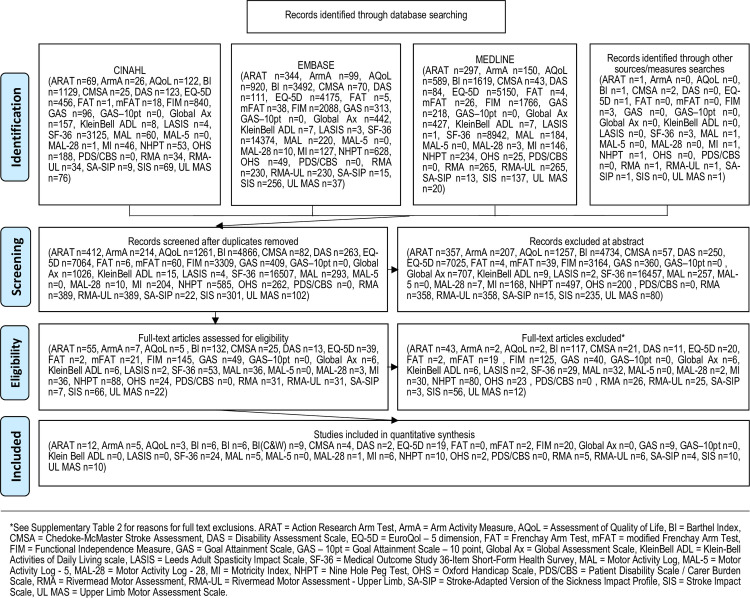
PRISMA flow chart.